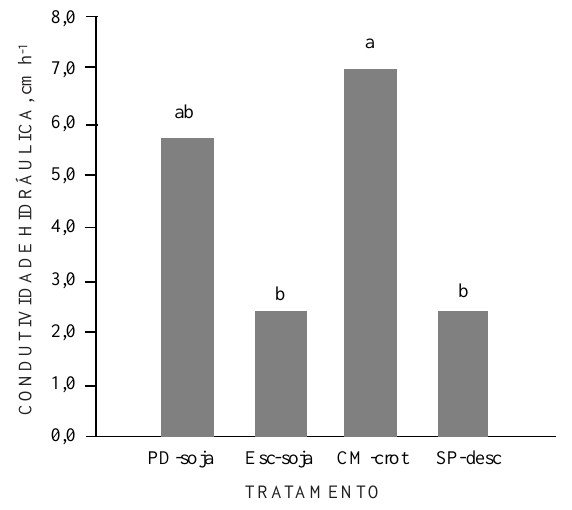
Figura 3. Condutividade hidráulica em solo saturado (K ) determinada no campo na ( qqqqq s) profundidade de 0,02 a 0,12 m, em solo sob diferentes sistemas de manejo. Médias seguidas de mesma letra não diferem estatisticamente entre si pelo teste DMS a 5 % de